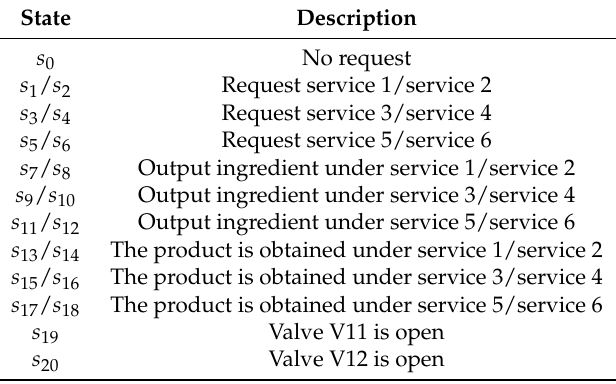
Table 3. Description of states in the tank